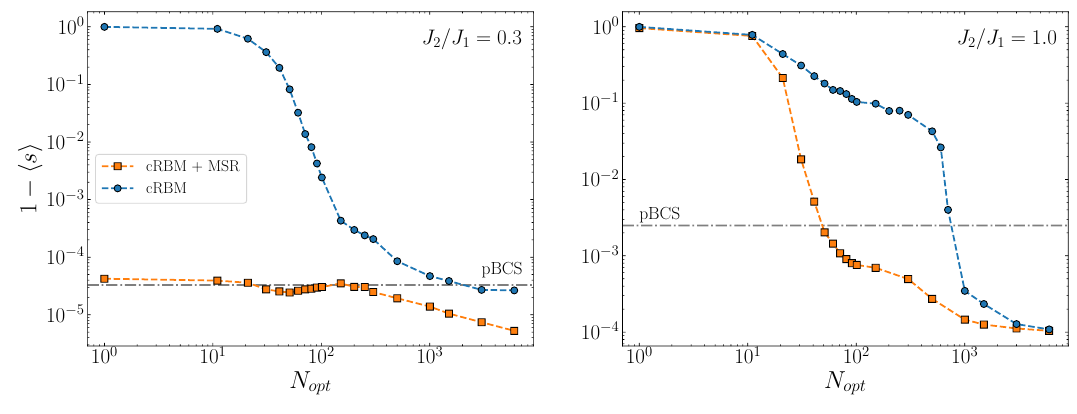
Figure 5: Evolution of the average sign defined in Eq. (9) during the optimization procedure of the cRBM state, for J Here, for each optimization step N variational